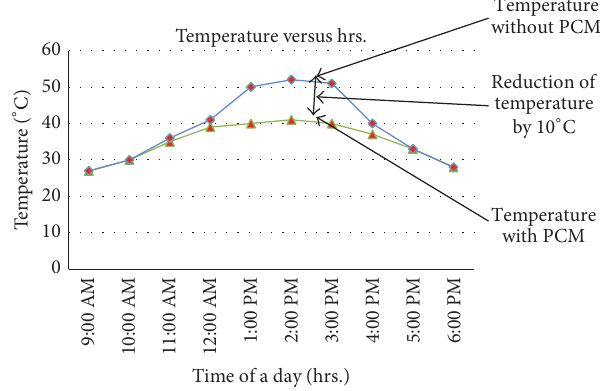
Time of a day (hrs.) Figure 9: Experimental temperature variation of the PV module with PCM and without